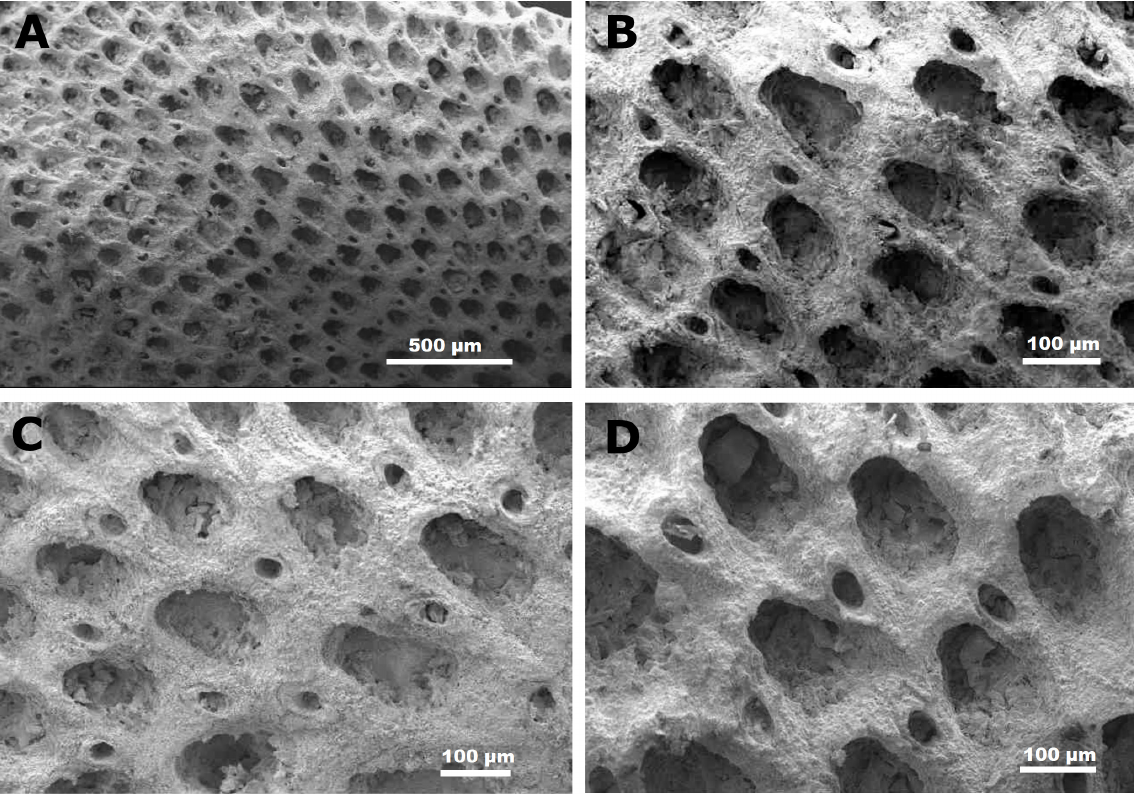
Fig. 5. Antropora gadhavii Guha & Gopikrishna, 2005 (GIS/B 0461). A . General view of the colony showing autozooids. B – C . Enlargement of the colony showing autozooid and interzooecial avicularia. D . Close-up of the colony showing autozooids with cryptocyst and interzooecial